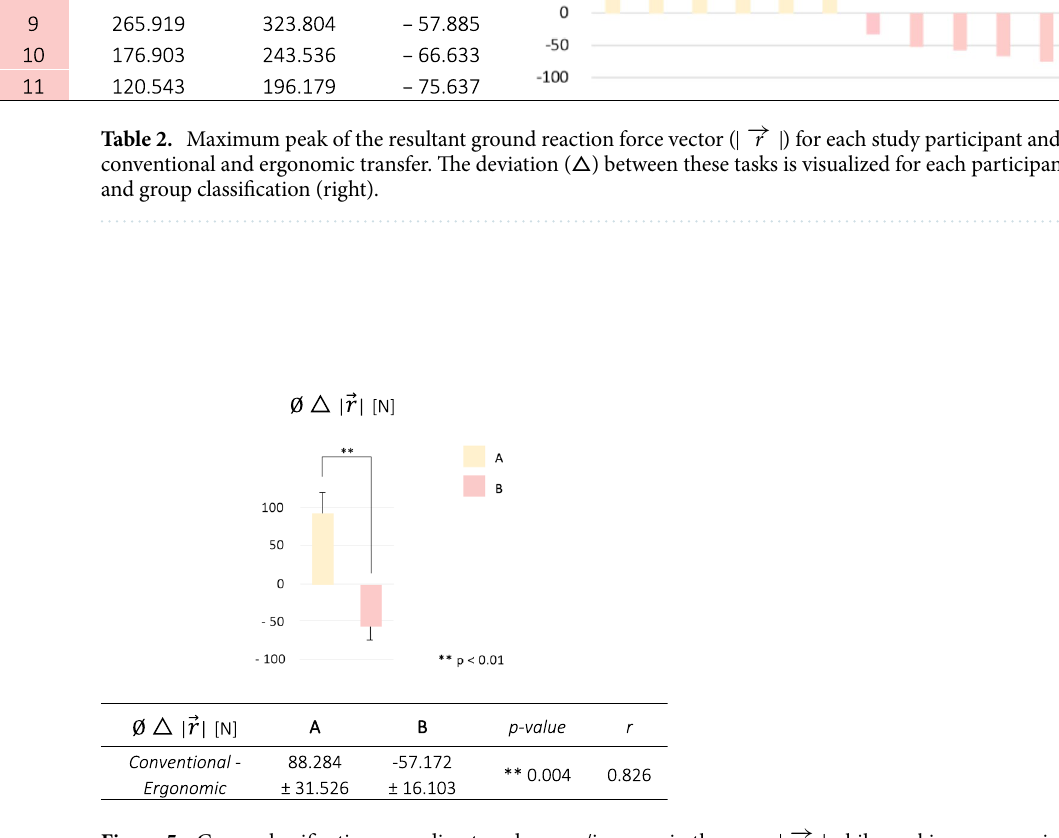
Figure 5. Group classification according to a decrease/increase in the mean | The p -value and effect size (r) for non-parametric statistical testing using the Mann–Whitney test are also